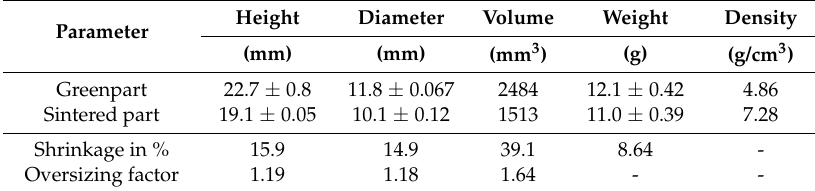
Table 4. Geometrical properties, mass and density of cylinders with 100% infill ( n = 6).